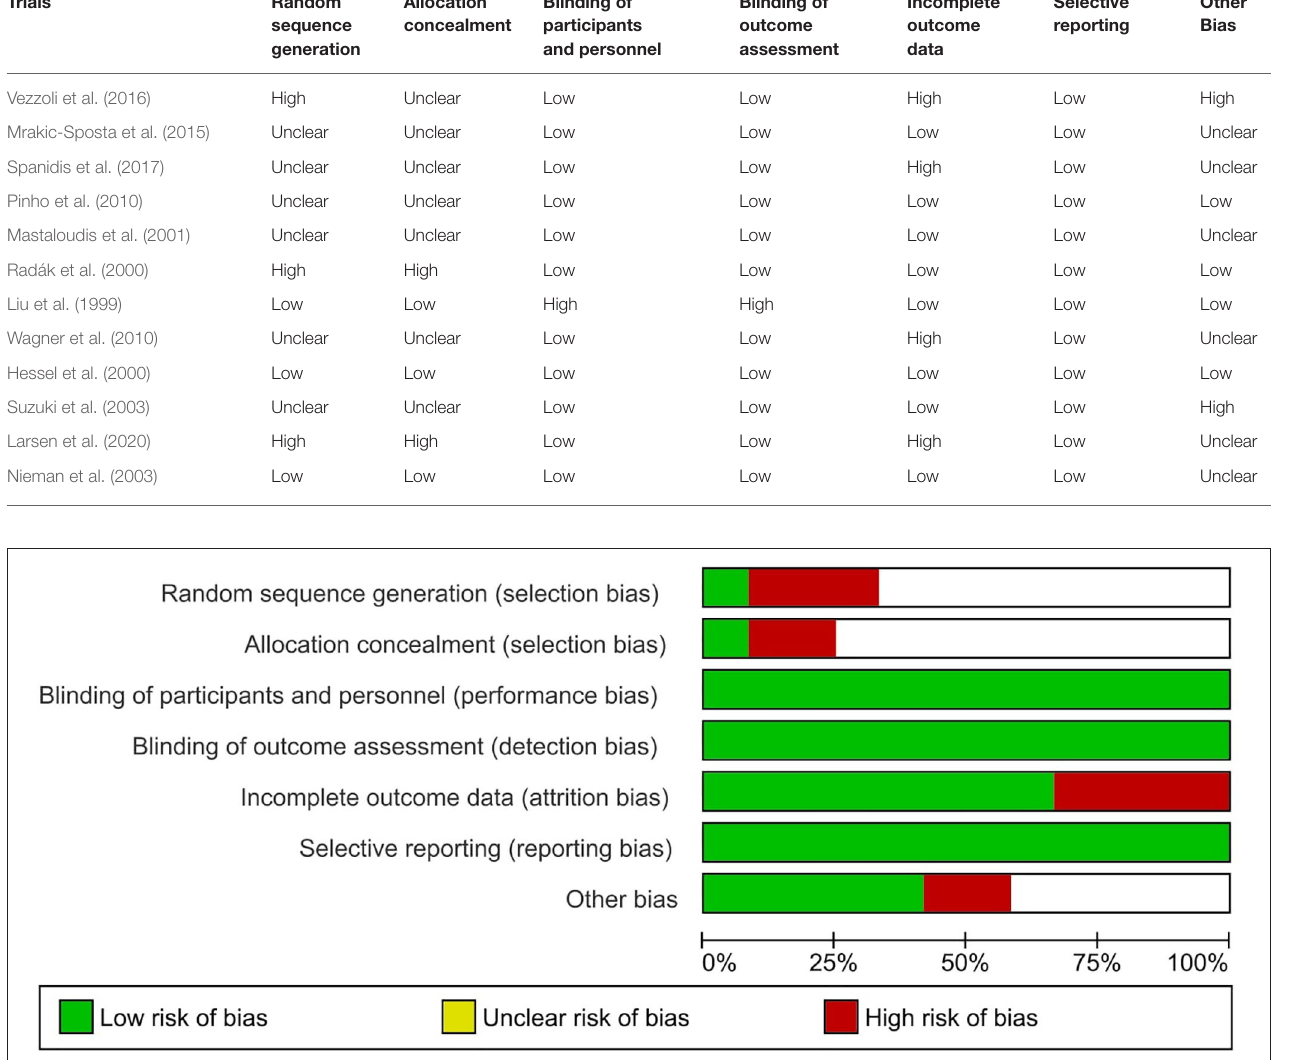
FIGURE 2 | Risk of bias evaluation of included